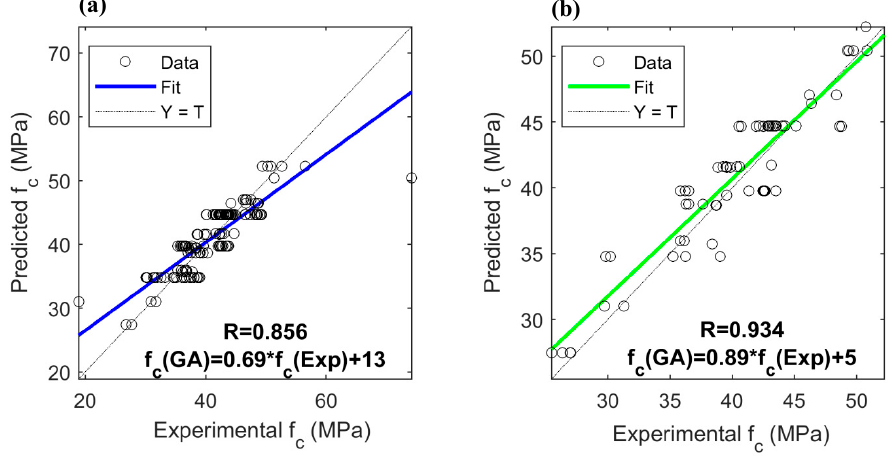
Figure 7. Correlation coefficients of different models: ( a ) training PSOANFIS, ( b ) testing PSOANFIS, ( c ) training GAANFIS, and ( d ) testing